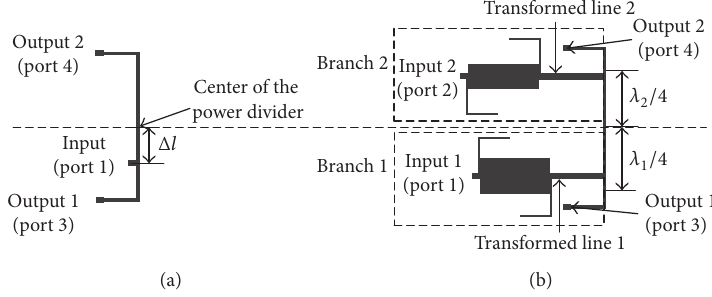
Figure 5: (a) Layout of the power divider. (b) Layout of the PDDN.